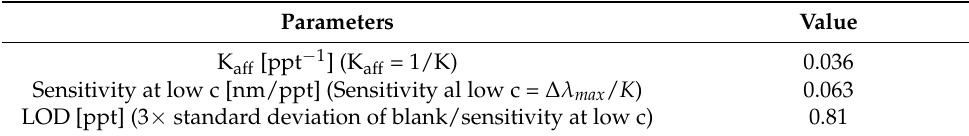
Table 2. Sensor chemical parameters for PFOA detection in Milli-Q water.